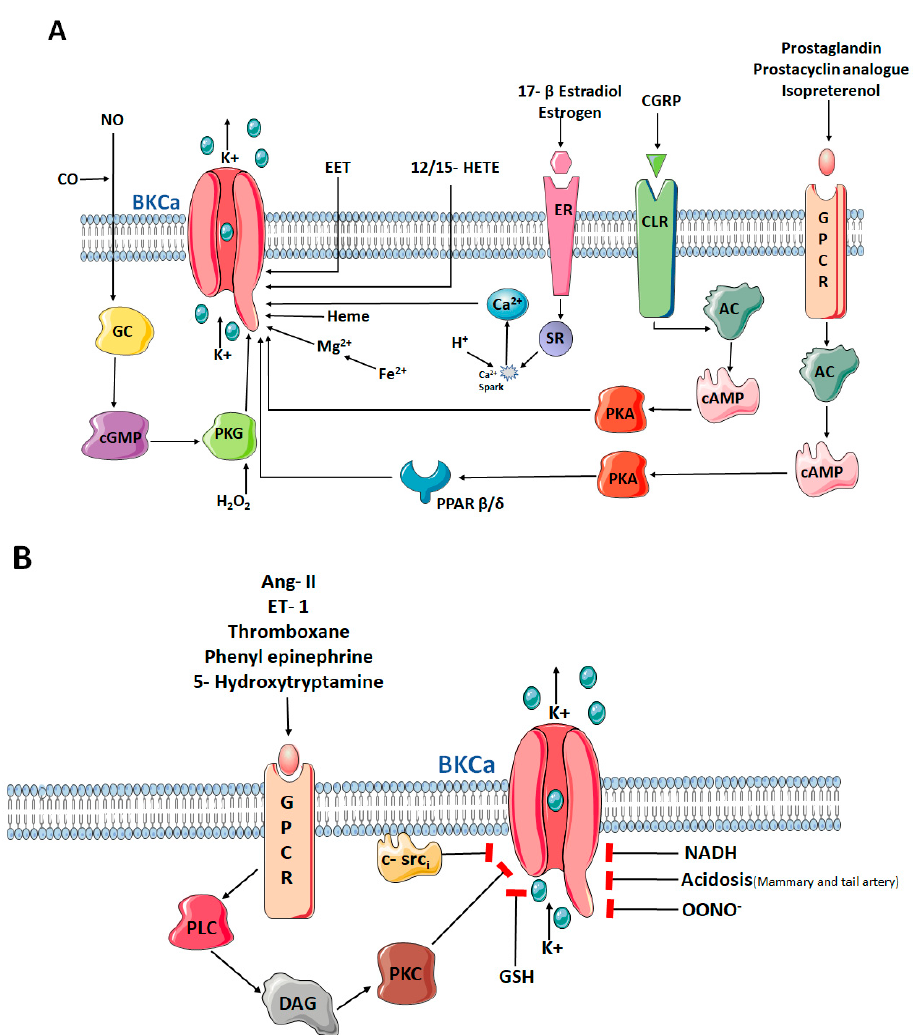
Figure 1. Intracellular and extracellular endogenous activators ( A ) and inhibitors ( B ) of BKCa channels. BKCa: Big/large conductance calcium activated potassium channels; NO: Nitric oxide; CO: Cabon monoxide; GC: Guanylyl cyclase; cGMP: Cyclic guanosine monophosphate; PKG: Protein Kinase G; H 2 O 2 : Hydrogen peroxide; K + : Potassium ion; Fe 2+ : Ferrous ion; Mg 2+ : Magnesium ion; EET: Epoxyeicosatrienoic acid; HETE: Hydroxyeicosatrienoic acid; ER: Estrogen receptor; SR: Sarcoplasmic reticulum; Ca 2+ : Calcium ion; GPCR: G-Protein coupled receptor; CGRP: Calcitonin gene related peptide; CLR: Calcitonin receptor-like receptor; AC: Adenylyl cyclase; PPAR: Peroxisome proliferator activated recetor; cAMP: Cyclic adenosine monophosphate; PKA: Protein kinase A. Ang II: Angiotensin II; ET-1: Endothelin-I; PLC: Phospholipase C; DAG: Diacylglycerol; PKC: Protein kinase C; c-srci: Tyrosine kinase src (inactivated); GSH: Glutatione; NADH: Reduced nicotinamide adenine dinucleotide; OONO − : Peroxynitrate. Figure created using the illustrations by Servier Medical Art by Srvier licensed under a Creative Commons Attribution 3.0 unported